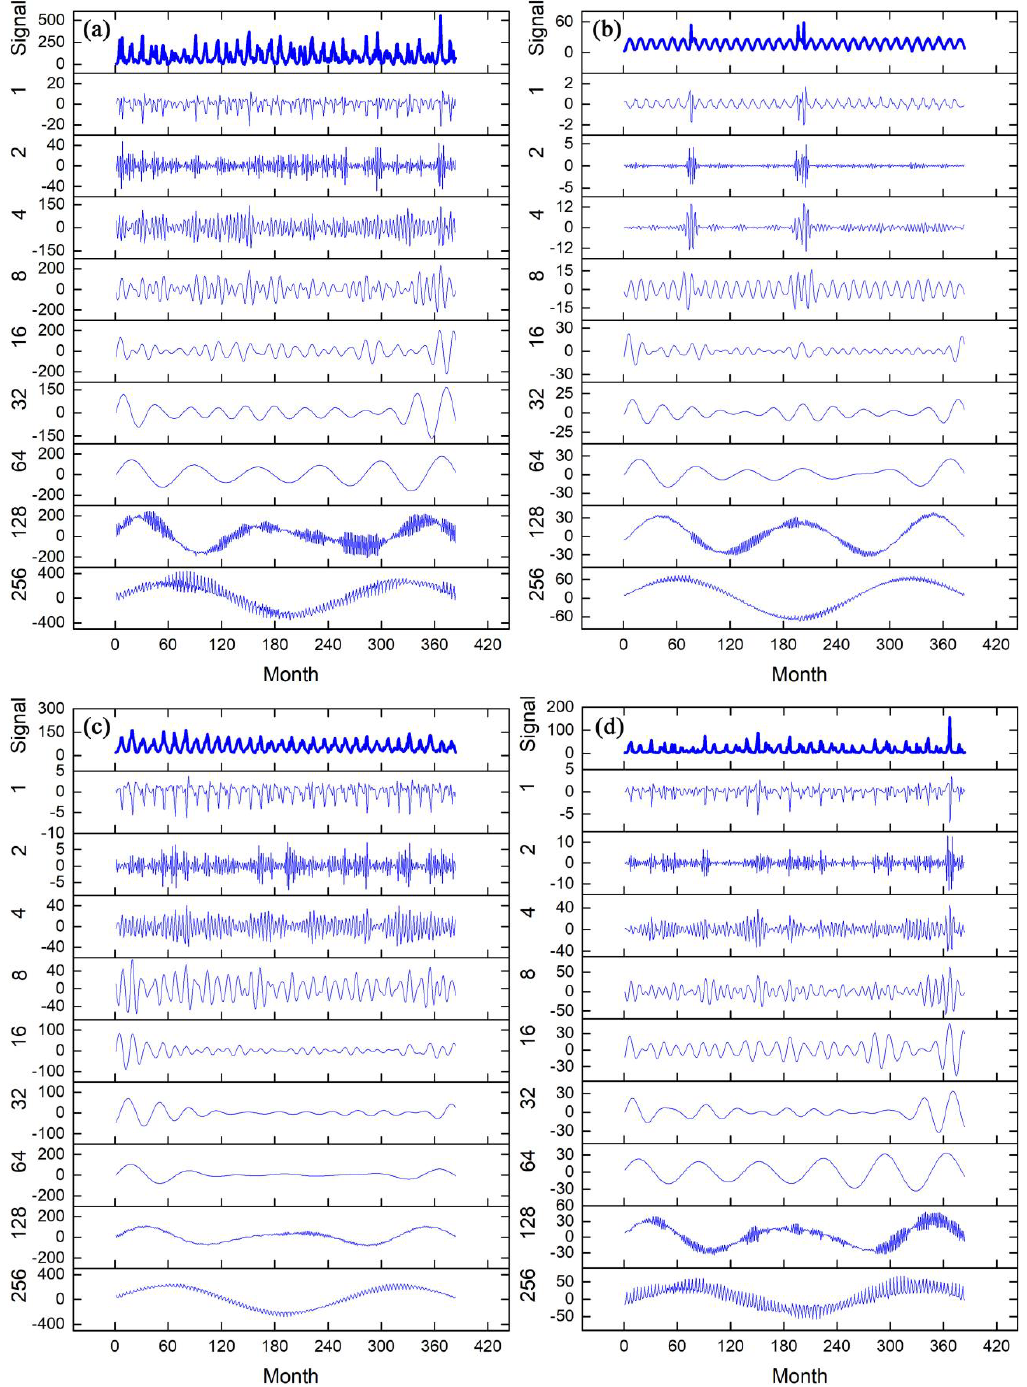
Figure 3. Multi-time-scale variations of monthly rainfall ( a ), temperature ( b ), evaporation ( c ) and runoff ( d